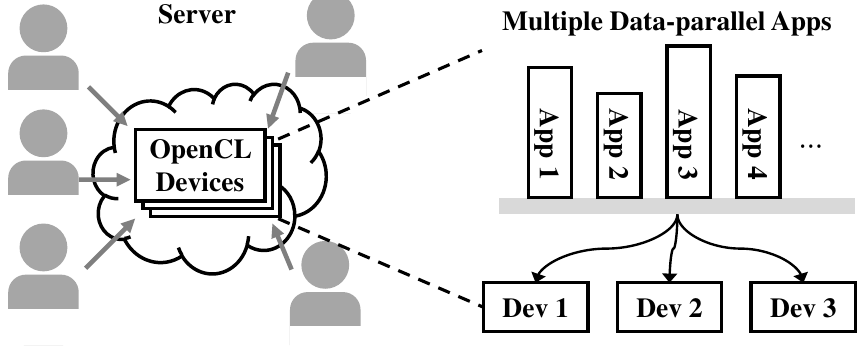
Figure 1. An example system where multiple users execute their own data-parallel